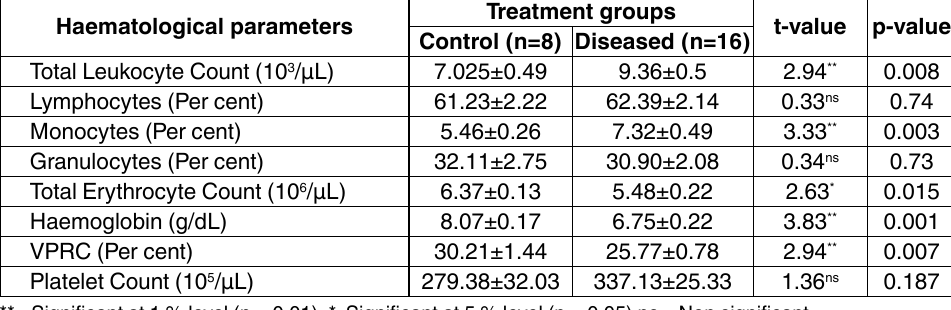
treatment groups